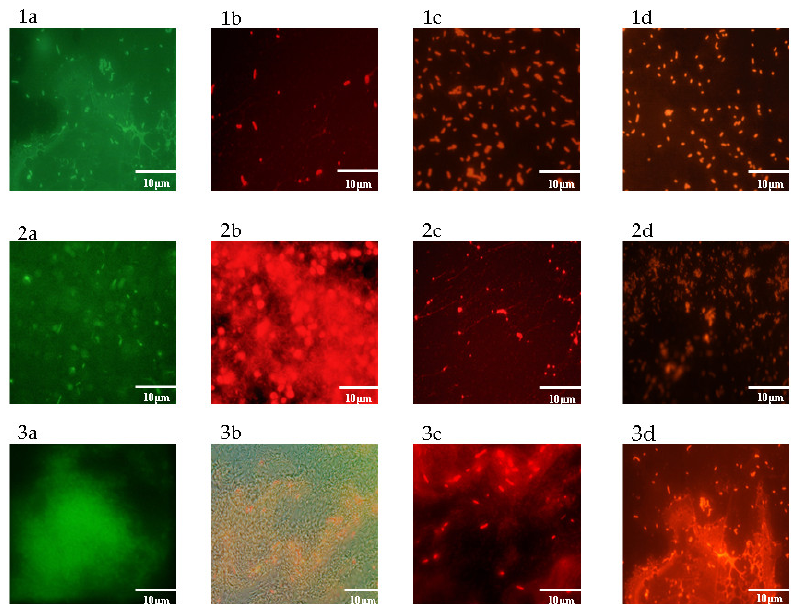
Figure 7. Images of light microscopy obtained by using “live / dead cells stain kit” for: S. agalactiae ( 1a ), C. albicans ( 2a ), and Lactobacillus spp. ( 3a ) mature biofilm; S. agalactiae ( 1b ), C. albicans ( 2b ) and Lactobacillus spp. ( 3b ) mature biofilm treated with L. x intermedia EO; S. agalactiae ( 1c ), C. albicans ( 2c ) and Lactobacillus spp. ( 3c ) mature biofilm treated with M. arvensis EO; S. agalactiae ( 1d ), C. albicans ( 2d ) and Lactobacillus spp. ( 3d ) mature biofilm treated with synergistic combination EO / EO. Green fluorescence labels live cells, whereas red fluorescence labels dead cells. The scale bars indicate 10 µ